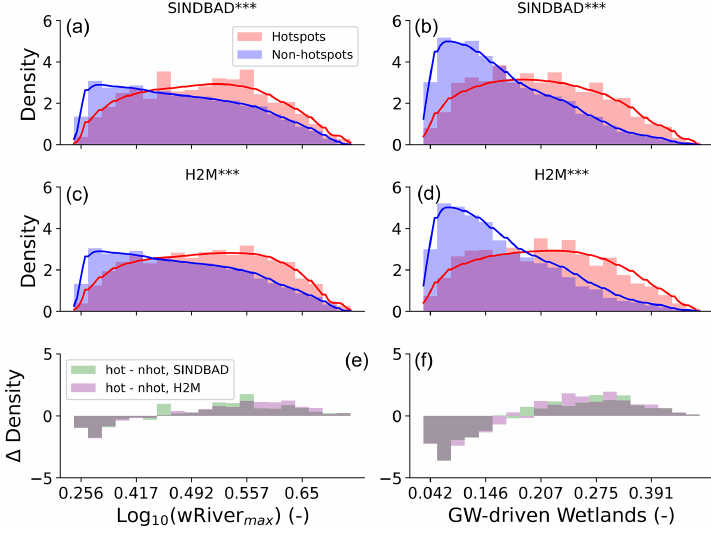
Figure B22. Same as Fig. 7 but using MSWEP instead of GPCP1dd for the precipitation forcing.